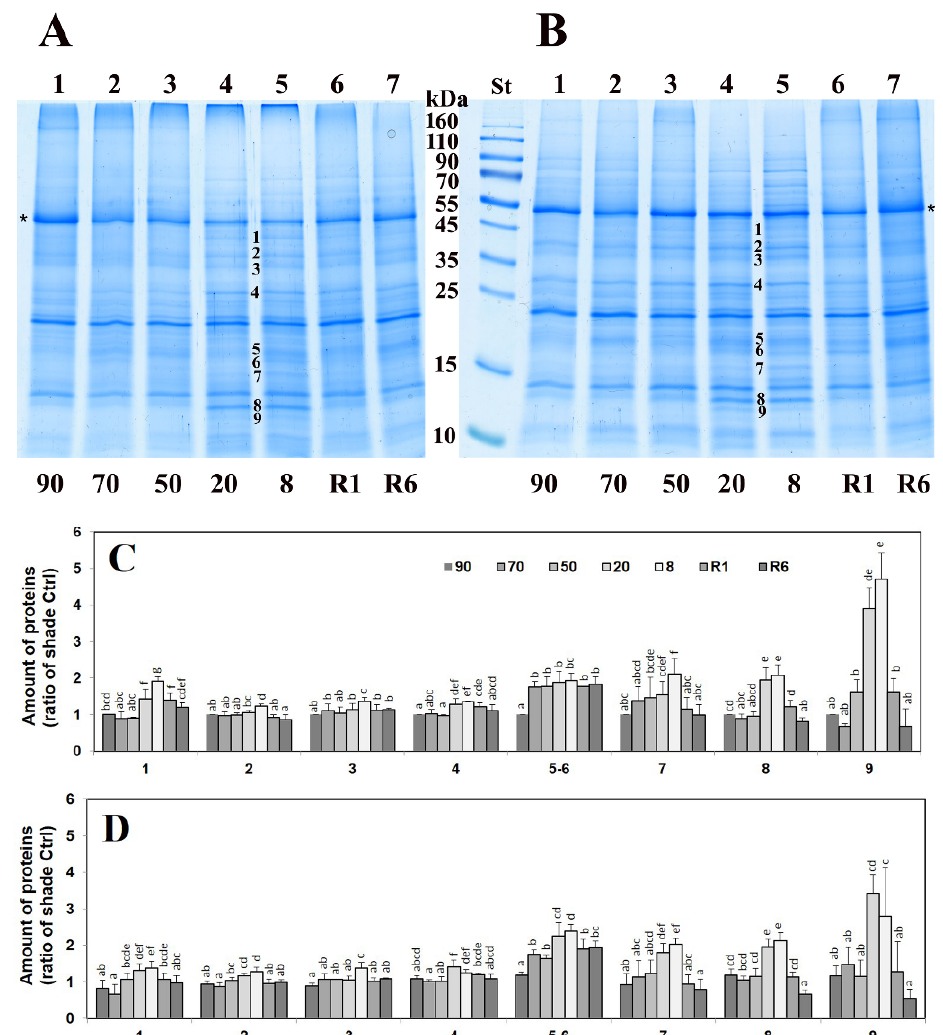
Figure 1. SDS PAGE pattern of total leaf polypeptides in H. rhodopensis shade ( A ) and sun ( B ) control plants (90% RWC), during dehydration (70, 50, 20, and 8% RWC) and after rehydration (1 and 6 days of rehydration; R1, RWC 50%, and R6, RWC 90%, respectively). ( A , B ) Coomassie Brilliant Blue-stained polypeptide patterns of controls (lanes 1), dehydrated leaves (lanes 2–5), and rehydrated ones (lanes 6 and 7). Approx. 10 µ g protein was applied per lane. St: Fermentas Page Ruler Prestained Protein SM0671 (Thermo Fisher Scientific, Waltham, MA, USA) standards. ( C , D ) Changes in the amount of the elevating leaf polypeptides numbered in ( A , B ) (1–9) in shade ( C ) and sun ( D ) ecotypes of H. rhodopensis . The relative protein amounts (pixel density of the protein bands; arbitrary unit) of numbered bands were expressed as the percentage of summa pixel density of lanes; for better comparison, values of each protein were normalized so that control samples of shade ecotype (90% RWC) were chosen as 1. Values are given as mean ± SD ( n = 3). Changes between shade and sun plants were statistically compared. Different letters within a graph indicate significant differences assessed by the Fisher LSD test ( p ≤ 0.05) after performing multifactor ANOVA. Asterisks (*) on ( A , B ) show the position of Rubisco large subunit on the